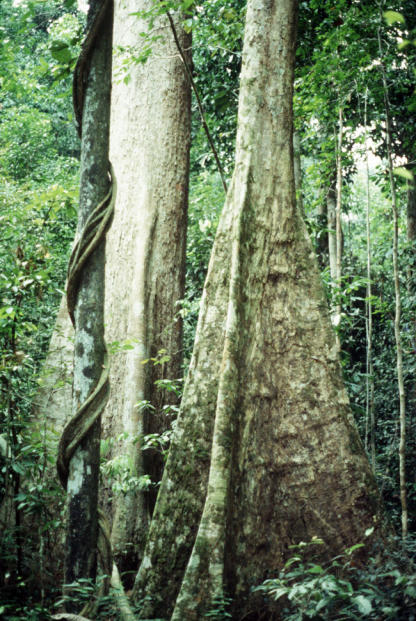
Tree trunks and vines at the Pasoh Forest Reserve, one of the last remaining examples of primary lowland tropical forest in peninsular Malaysia. (Photo: T. Seidler)